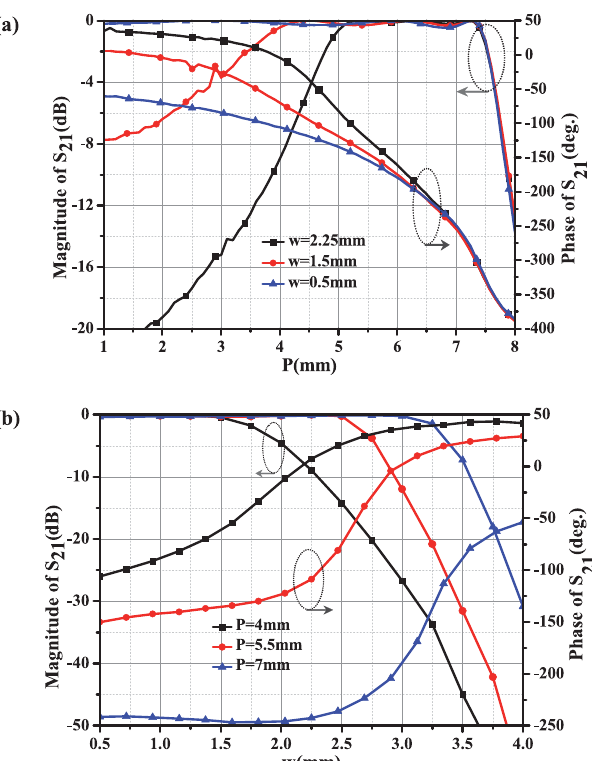
Fig. 4. The effect of size of MNMS unit on the transmission phase and magnitude of S 21 , (a) P and (b) w .